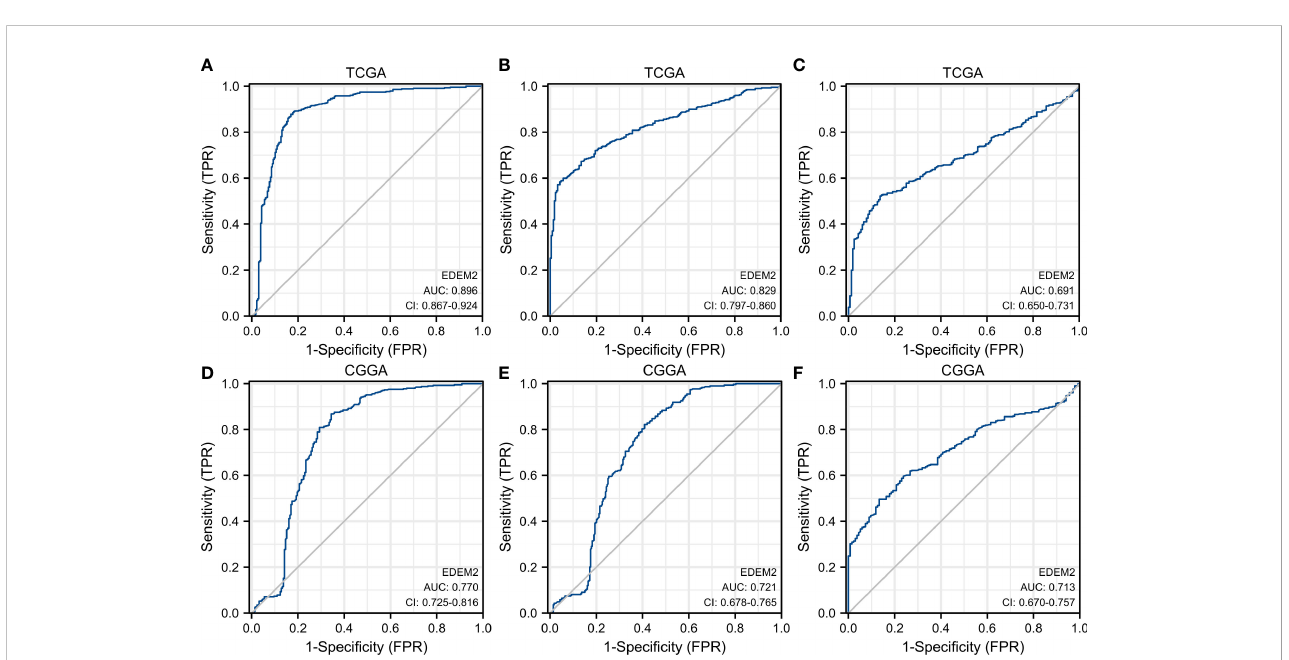
FIGURE 3 ROC curve to test the value of EDEM2 to identify different pathological features. (A – C) WHO grade, IDH status, 1p/19q status in TCGA. (D – F) WHO grade, IDH status, 1p/19q status in the